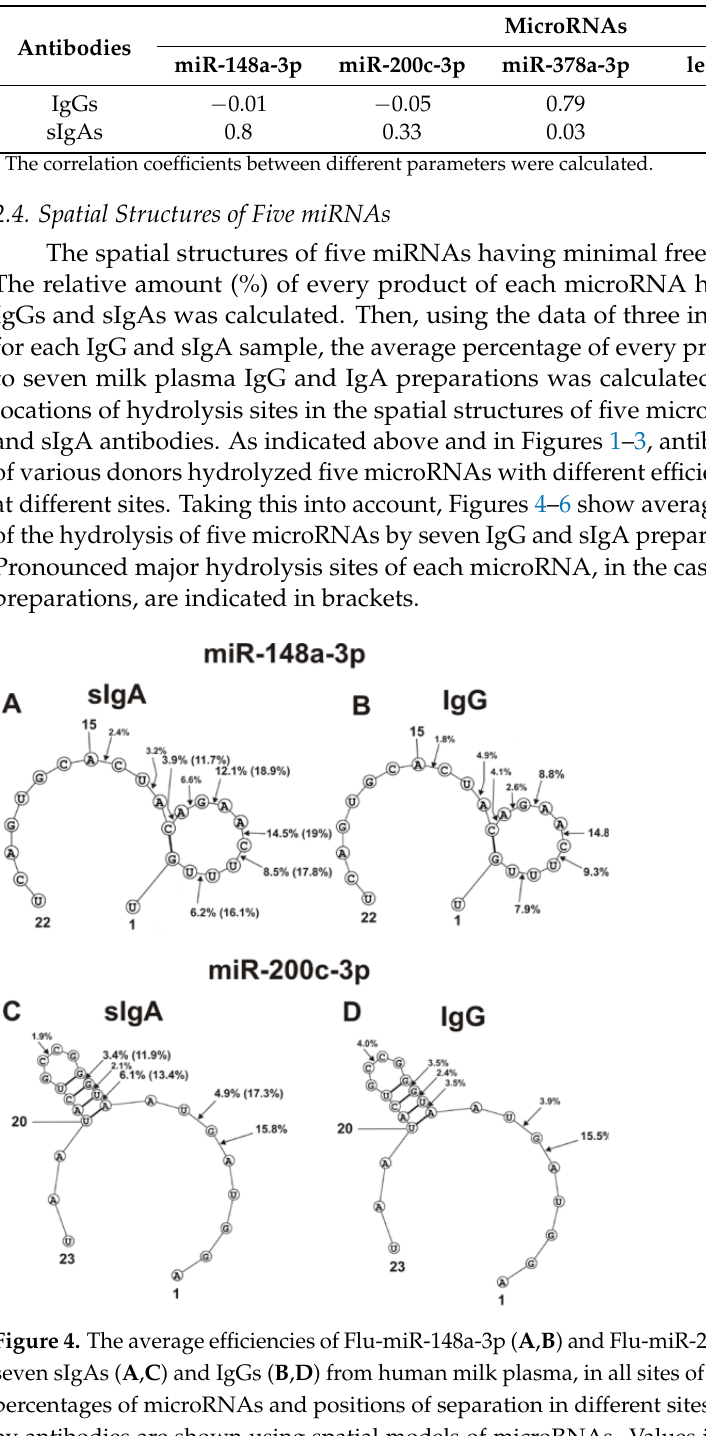
Table 5. Values of correlation coefficients between plasma microRNA concentrations, and relative activities of seven IgGs and sIgAs in the hydrolyses of five microRNAs * .